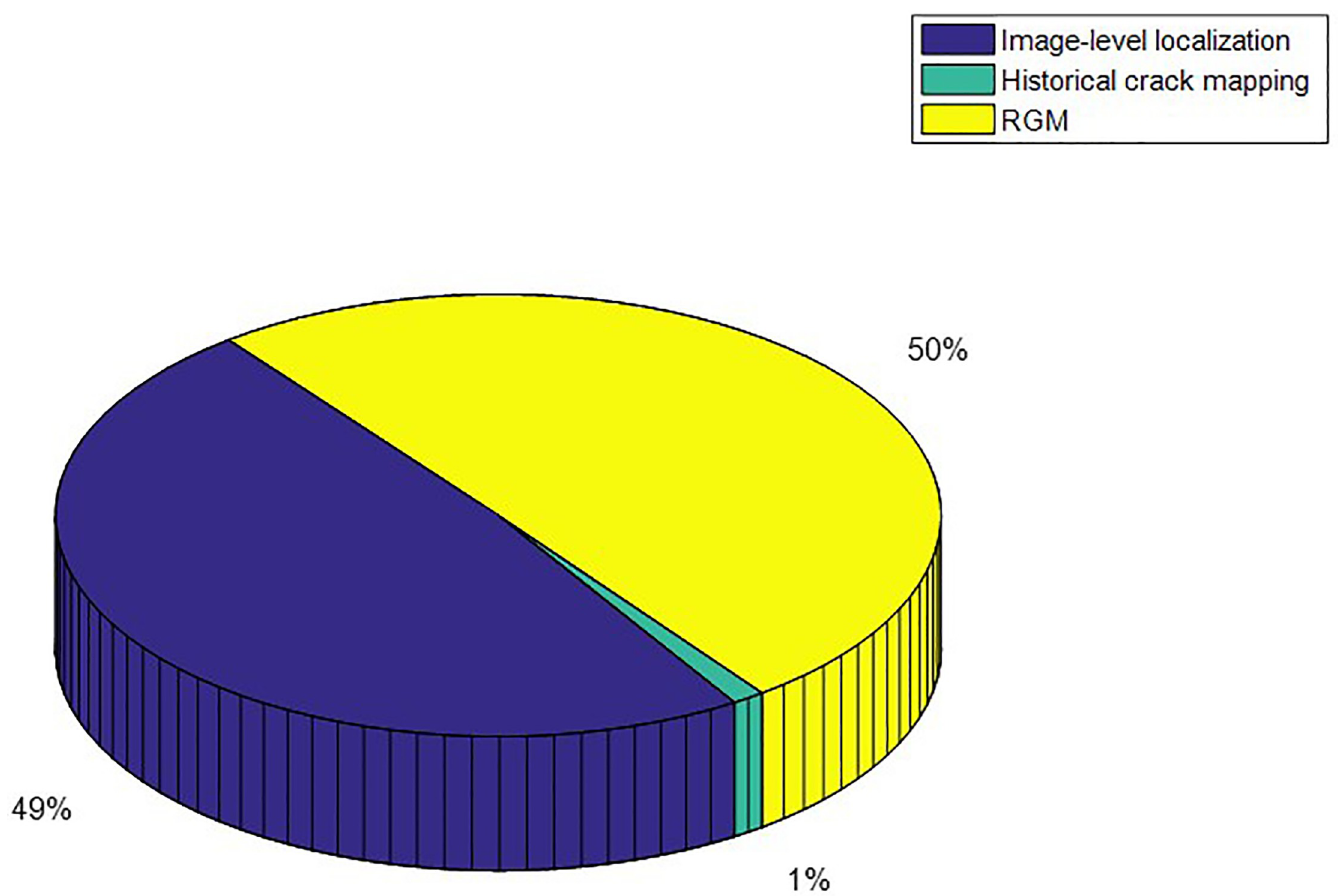
Fig 12. Time consumption of the proposed method.